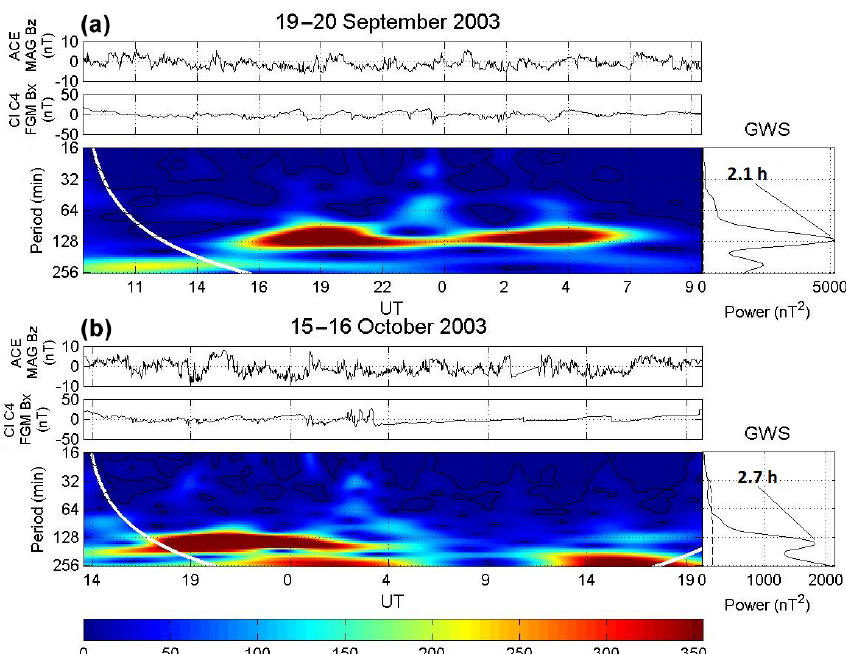
Figure 4. Cross-wavelet spectrum between ACE IMF B z component and Cluster C4 B x component for the (a) 19–20 September 2003 tail crossing (T2) and for the (b) 15–16 October 2003 tail crossing (T5). The color bar is the same for (a) and (b) . The two global spectra (GWS) are shown on the right. The thick white line shows the cone of influence (COI) limits. The cross-wavelet analysis confidence level of 95% is marked by black lines in the wavelet plot. Continuous wavelet spectrum background from red noise models is indicated in the GWS plot as a dotted black line, which for very low noise levels may not be visible in subsequent figures as the power range plotted changes in each figure.